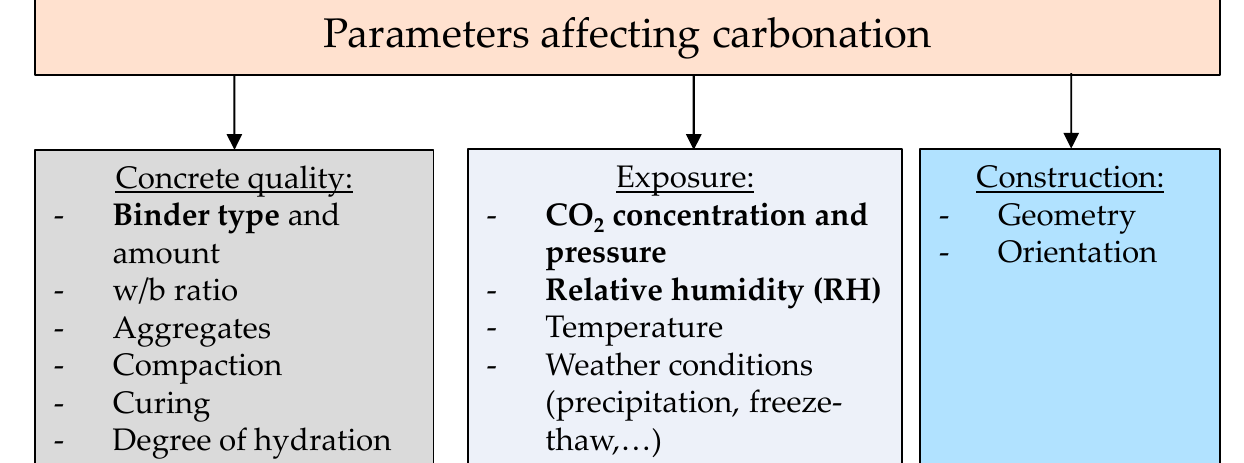
Figure 1. Parameters affecting the carbonation propagation of cementitious materials. Here, only the bold parameters marked in grey are investigated and therefore explained in more detail.